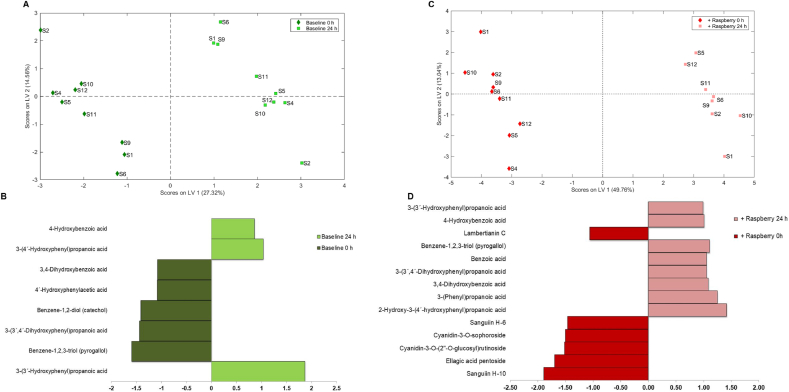
Multi-Level Partial Least Squares-Discriminant Analysis (ML-PLSDA) plots of phenolic composition of baseline ileal samples pre-raspberry consumption (A and B) and post-raspberry consumption (C and D) before (red) and after (green) 24 h of fecal fermentation. Score plots are Figures A and C and loadings weights plot for component 1 are Figures B and D. Cut off VIP value set at 0.9. (For interpretation of the references to color in this figure legend, the reader is referred to the Web version of this article.)